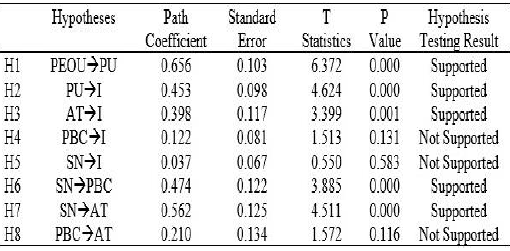
Table 5: Results of R2 and R2 Adjusted